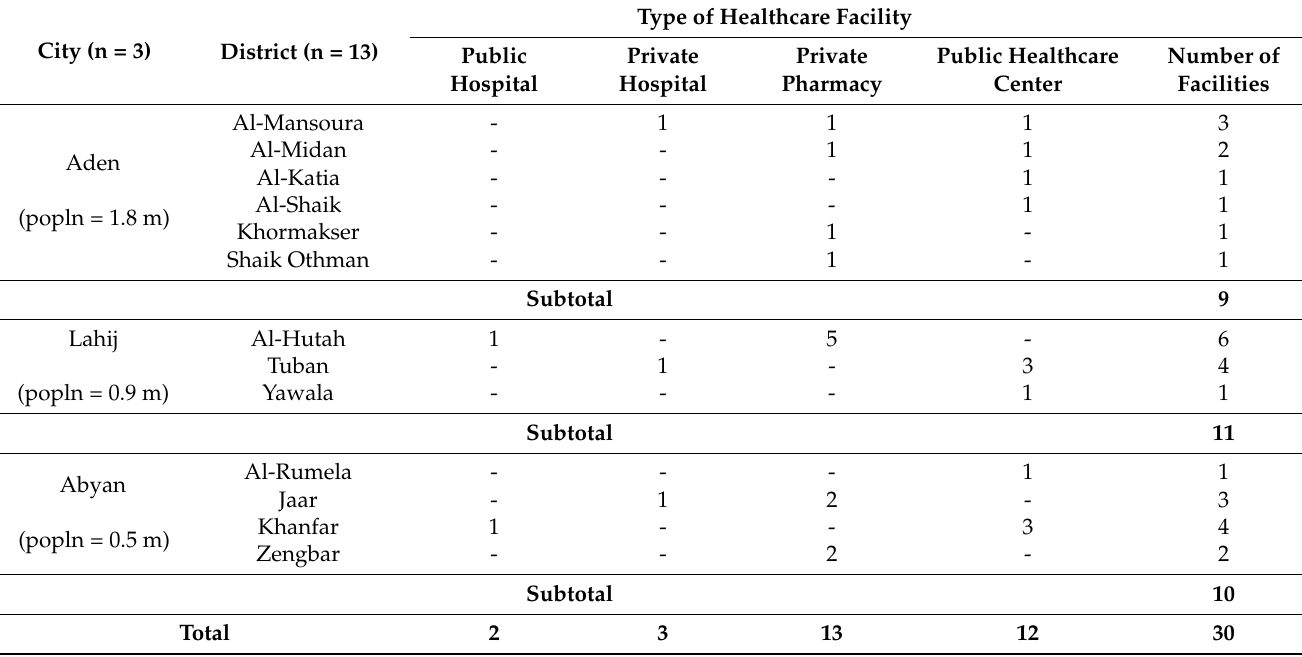
Table 1. Cities, districts, and types of facility included in the